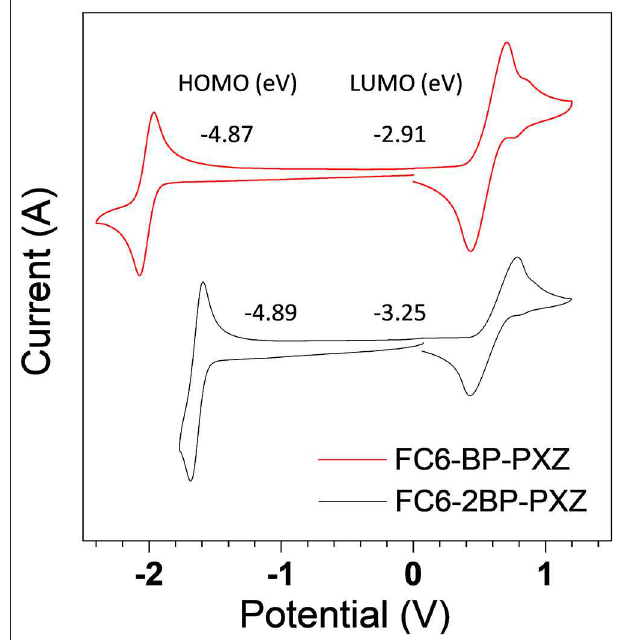
FIGURE 4 | Cyclic voltammograms of FC6-BP-PXZ and FC6-2BP-PXZ measured in acetonitrile containing 0.1M tetra- n -butylammonium hexafluorophosphate. Scan rate: 100mV s − 1